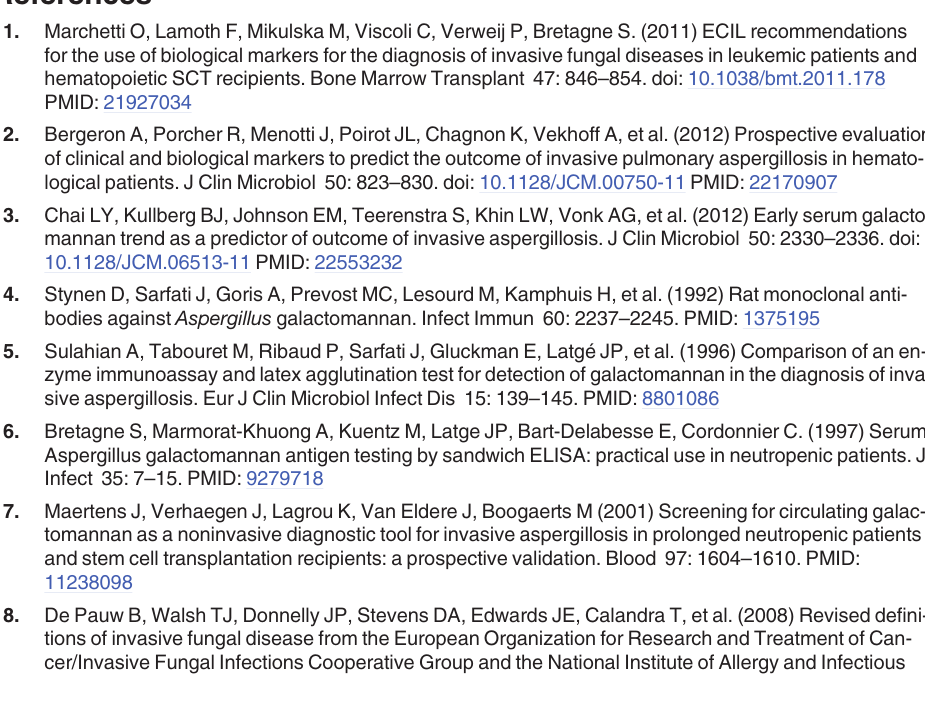
S1 Data Table. S1